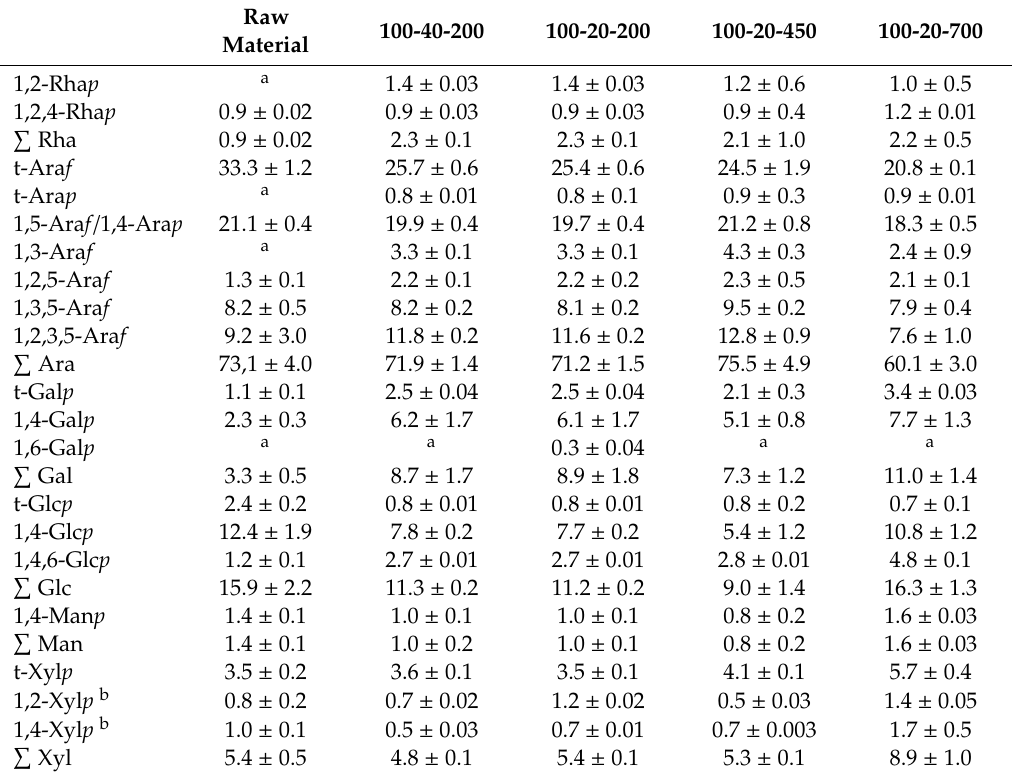
Table A5. Glycosidic linkages (partially methylated alditol acetates; mol%) of soluble dietary fiber of raw and extruded apple pomace (mean value ± range / 2, n = 2). t: terminal, p : pyranose, f : furanose, Rha: rhamnose, Ara: arabinose, Gal: galactose, Glc: glucose, Man: mannose, Xyl: xylose.